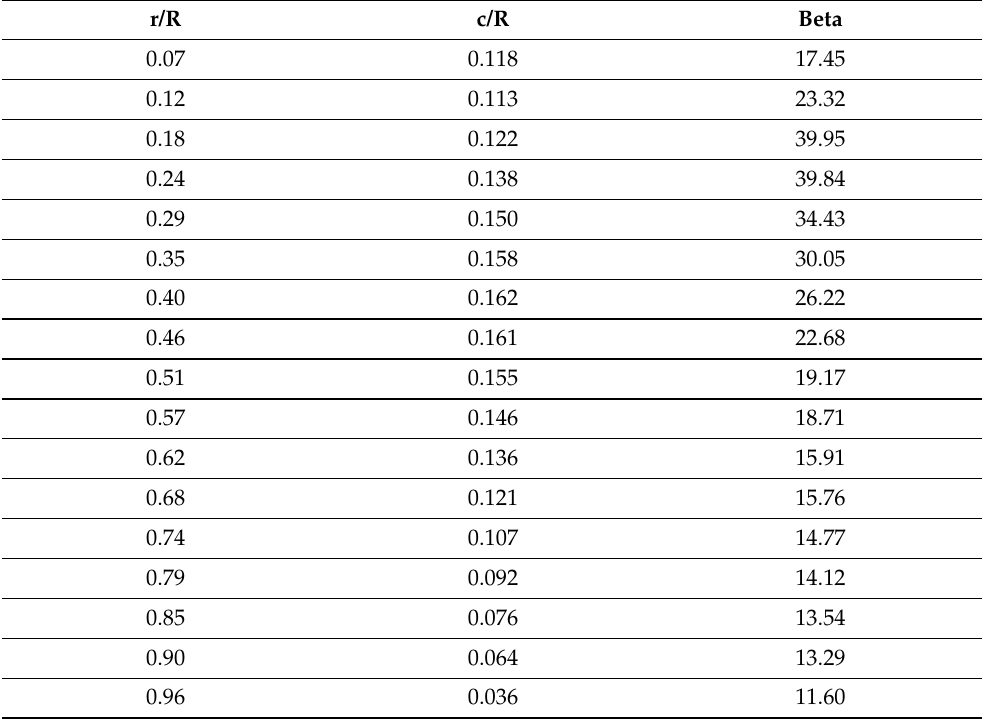
Table A3. APC 18 × 10 propeller